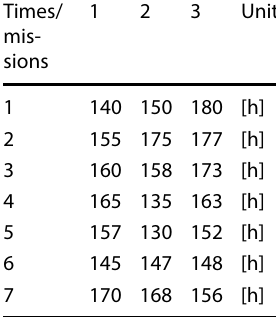
Table 2 Duration of windows time in each mission